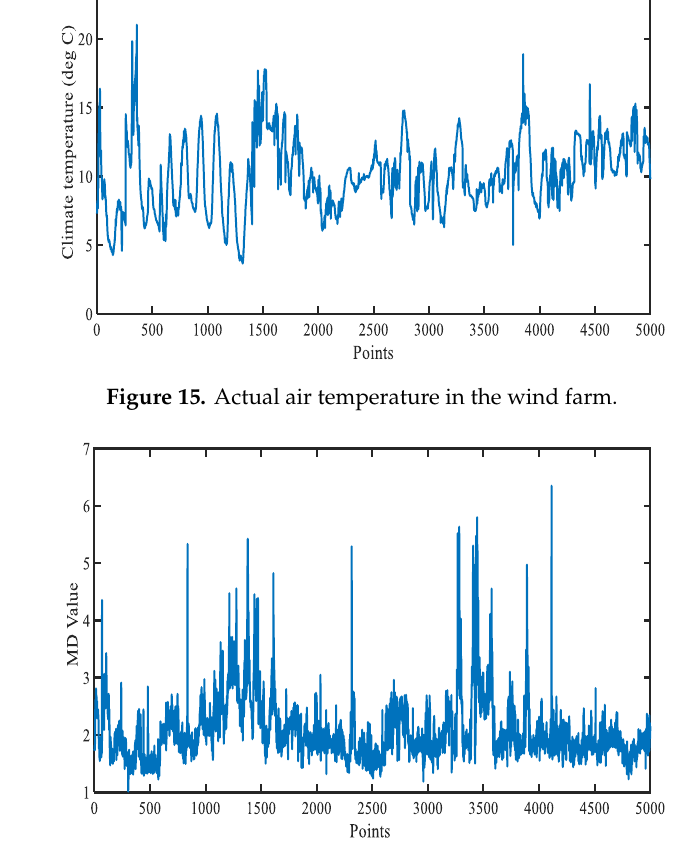
Figure 16. Mahalanobis distance value for prediction model input.